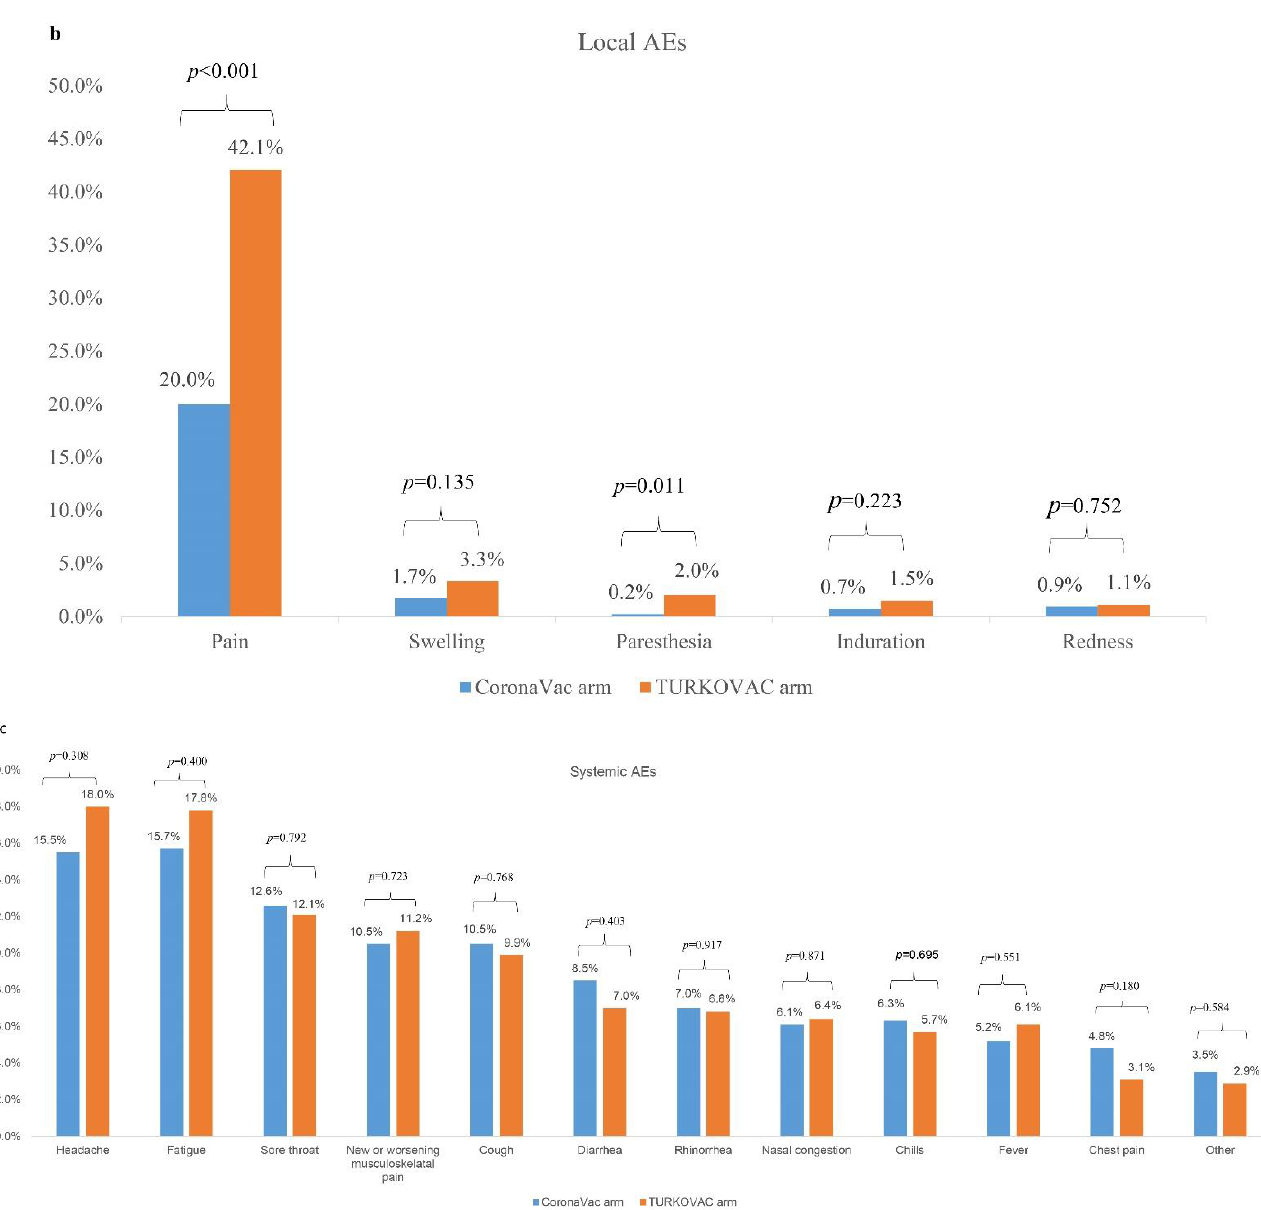
Figure 4. ( a ) Overall adverse events, ( b ) local adverse events, and ( c ) systemic adverse events in the CoronaVac and TURKOVAC arms. AEs, adverse events.